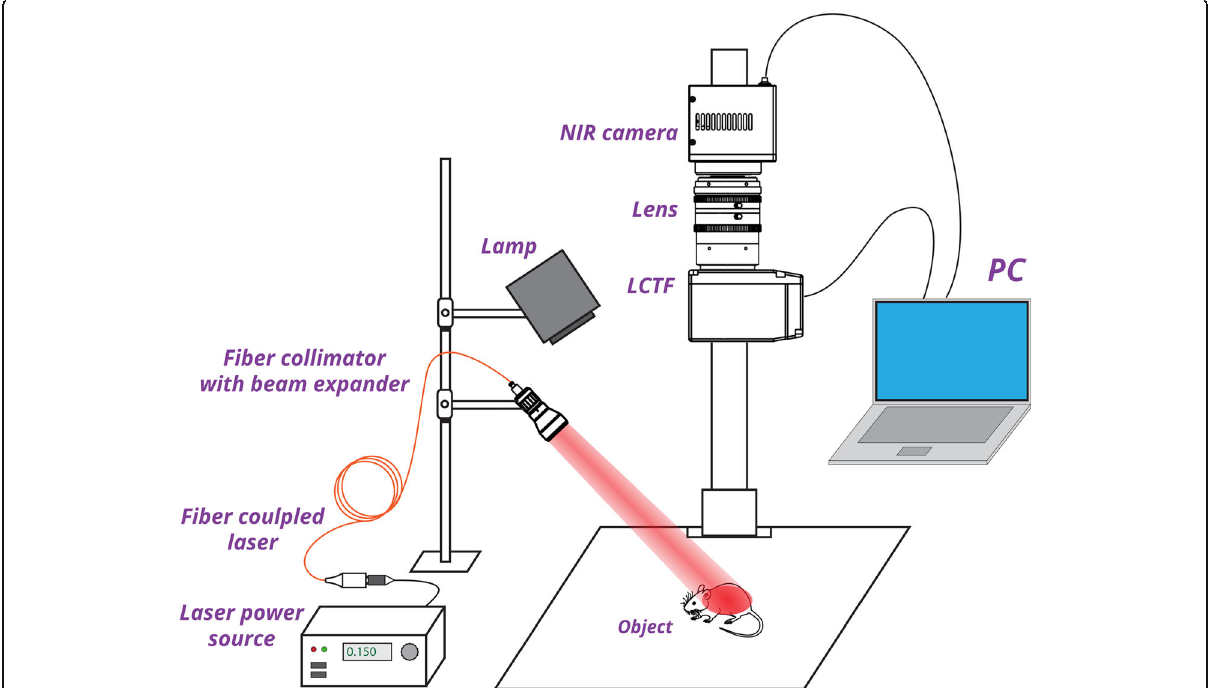
Fig. 2 Schematic diagram of the NIR-SWIR hyperspectral imaging